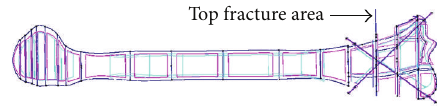
Table 2: Number of nodes and elements used to generate the two finite element meshes. Model Number of nodes Number of elements Parallel K-wire fixation 4907 21387 treatment model Crossing K-wire fixation 5660 treatment model